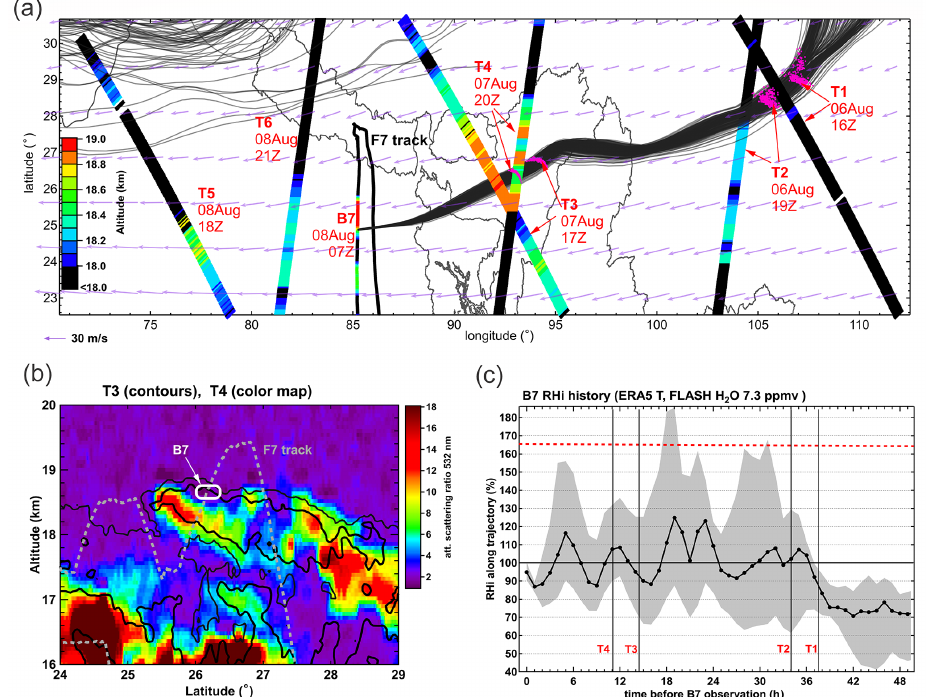
Figure 9. Evolution of cloud occurrence and RHi along the back trajectories released from B7 (H 2 O enhancement at 410K in F7). (a) Back trajectories (black curves) and ground tracks of CALIPSO and CATS satellite lidars colour coded by the cloud top altitude. The magenta circles mark the locations of the tracked parcels at the time of the nearest satellite transacts. The red labels indicate the transacts number (T1–T6) and its UTC. The arrows are wind vectors (ERA5) interpolated at the 410K level. The track of the F7 flight is shown as solid curve with altitude colour coding. (b) Attenuated scattering ratio (SR) for T3 (contours, 3 and 6 SR units) and T4 (colour map). The white oval shows the latitude–altitude location of the B7 parcels at the time of T4 transect. The grey dashed curve is the projection of the F7 flight track onto the lidar section. Note that the location of B7 parcels matches the evaporating part of the cloud. (c) Evolution of RHi along the back trajectories computed using ERA5 temperatures and measured H 2 O mixing ratio in B7 (7.3ppmv). The shading indicates 2 standard deviations, the vertical lines with red labels mark the timing of satellite transacts, and the red dashed line shows the homogeneous freezing threshold for the given temperature and